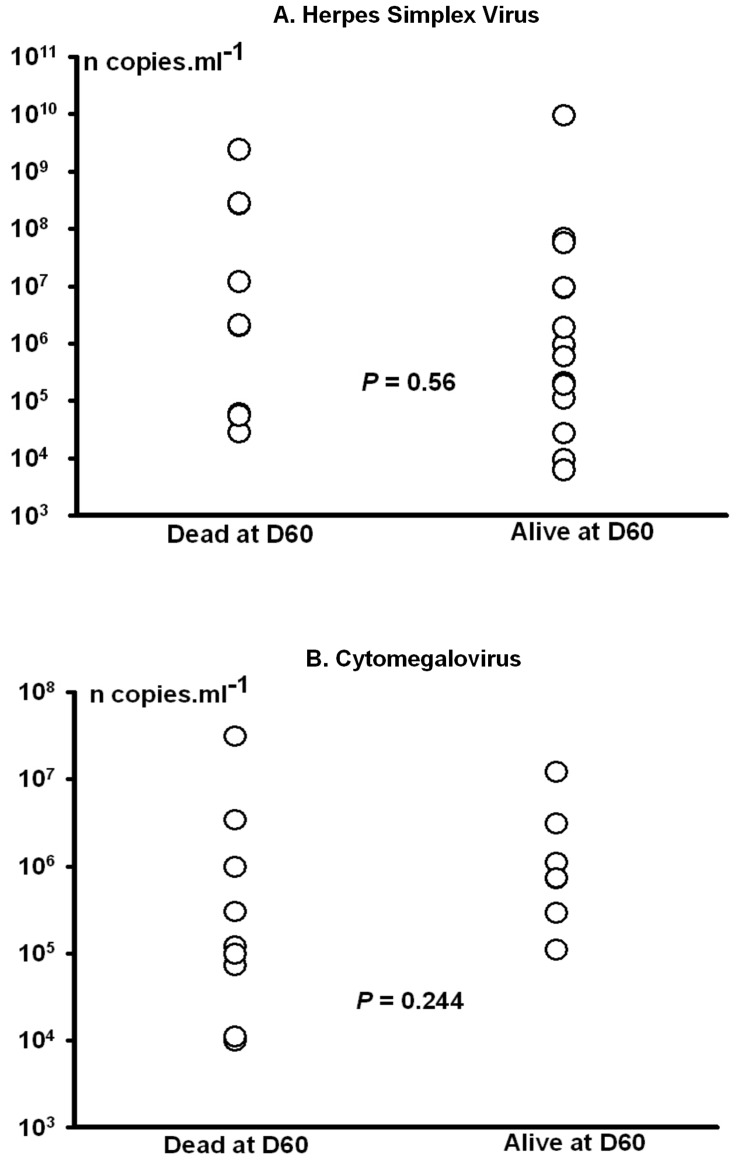
Viral load on bronchoalveolar lavage for herpes simplex virus (
Figure 1A
) and cytomegalovirus (
Figure 1B
) according to mortality at day 60.